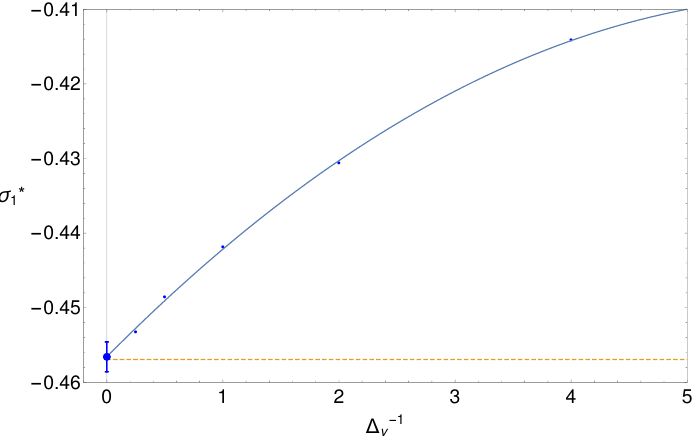
Figure 15 . Lower bounds on the rescaled variable σ ∗ as a function of ∆ − 1 , for σ ∗ = 0 . The blue v 1 2 line is a quadratic interpolation in ∆ − 1 . The extrapolation to the flat space limit is presented as a v larger blue point with a non-rigorous error-bar, which we estimated by performing extrapolations of different degree in ∆ − 1 . We observe an excellent match with the flat-space value, represented by v the yellow